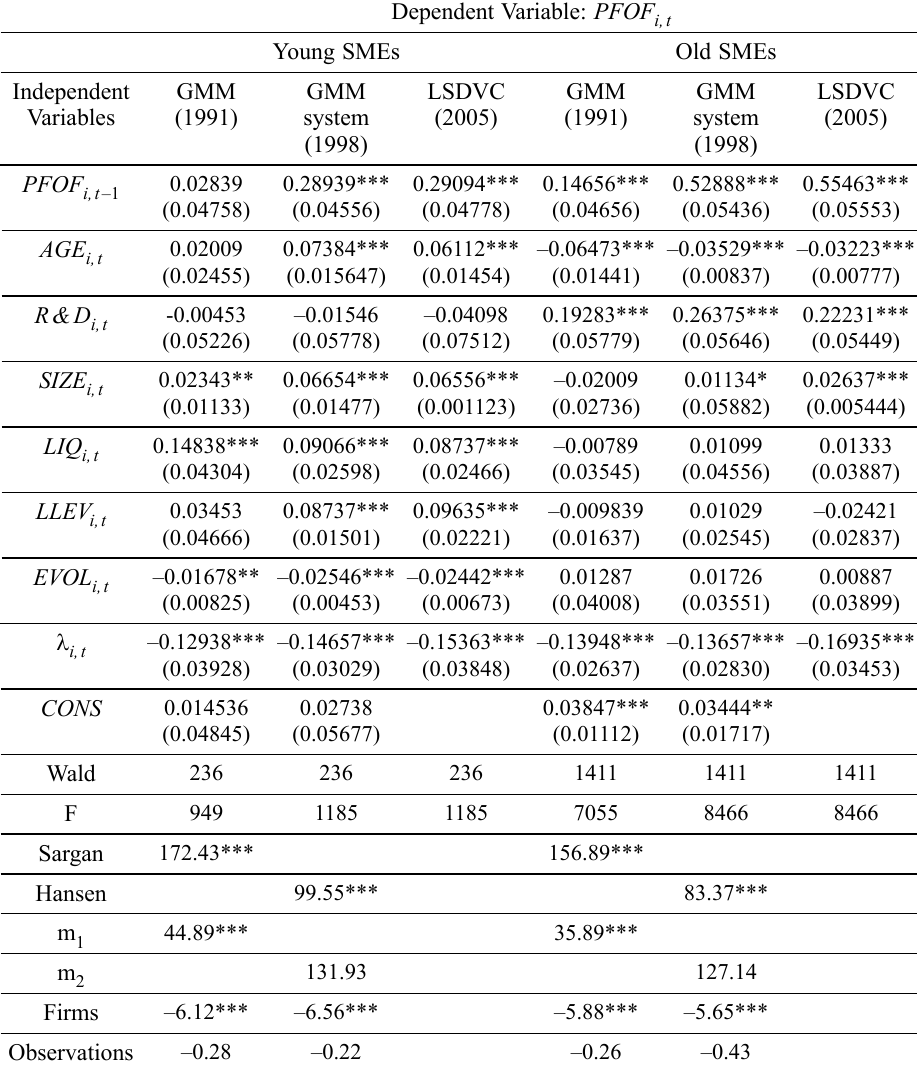
Table A2. Determinants of profitability – Young SMEs and Old SMEs – alternative criterion for selecting SMEs based on